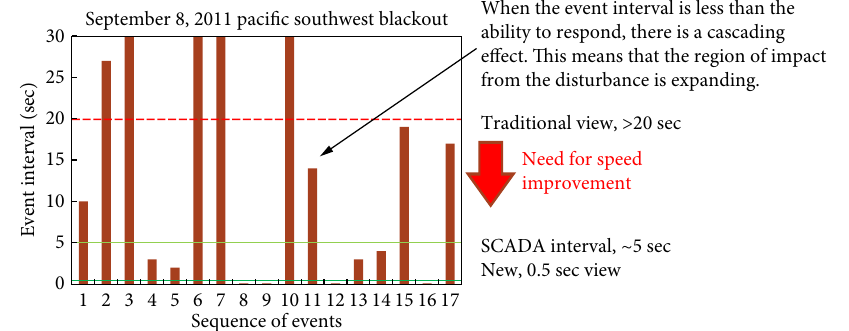
Fig. 7 Sub-second parallel state estimation performance in the Pacific Southwest Blackout in